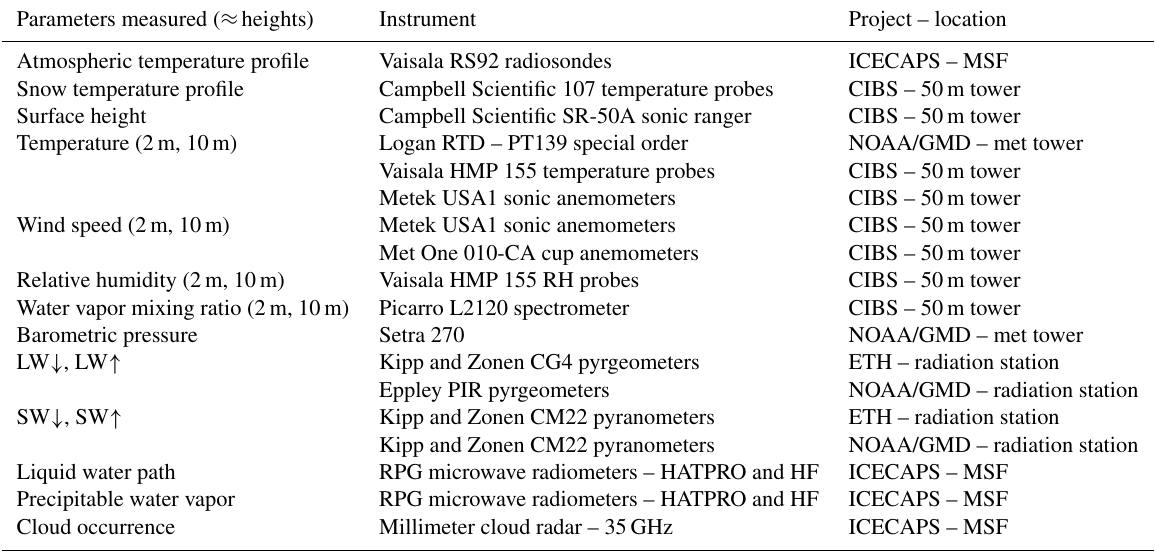
Table 2. List of measurements at Summit Station used in this study. Nominal heights are given for measurements made at two levels. Parameters measured ( ≈